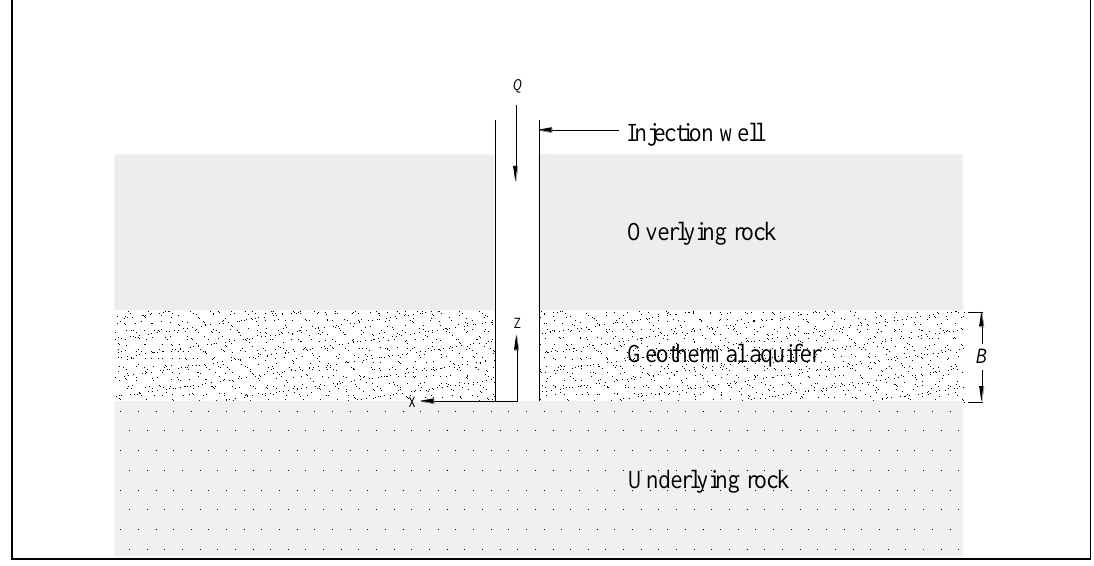
Figure 1. Schematic representation of the confined geothermal aquifer with the injection well.